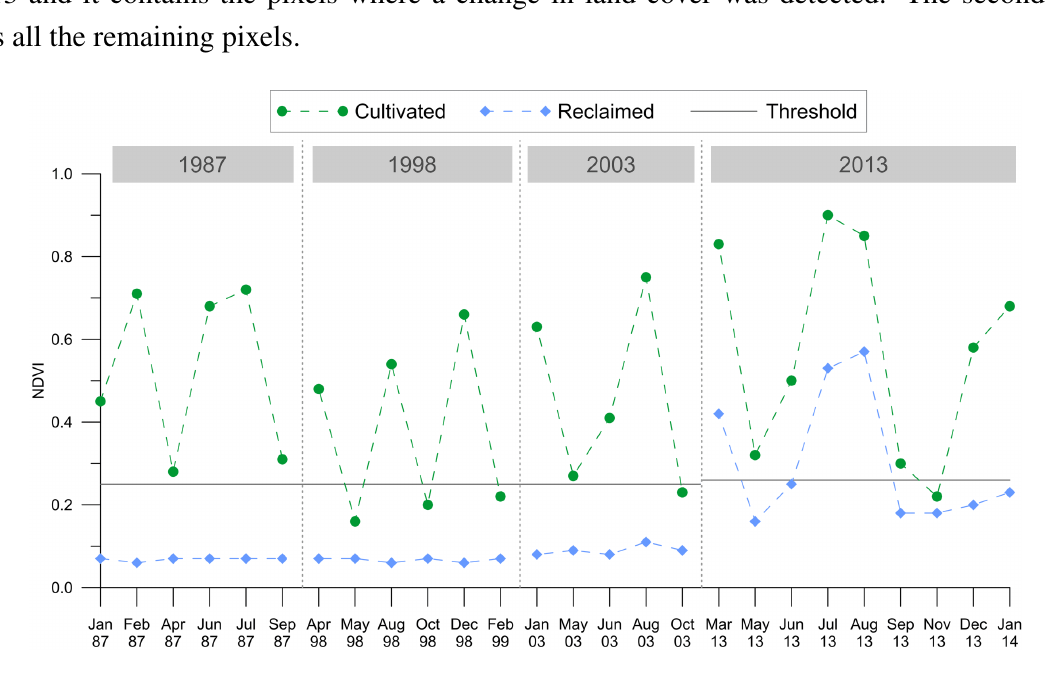
Figure 4. NDVI time series of two pixels (see Figure 6 for location). The first ( green circles ) belongs to a field under cultivation since 1987, while the second ( blue diamonds ) belongs to land reclaimed in 2011. The continuous grey line indicates the threshold of the NDVI